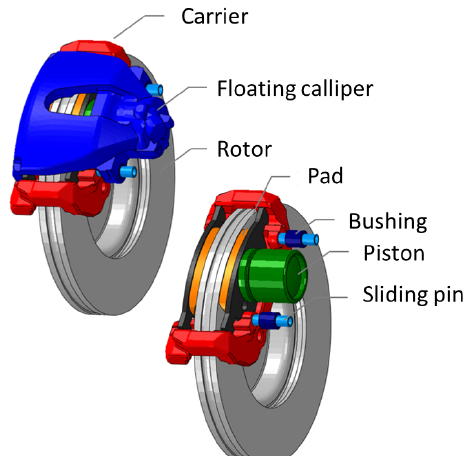
Fig. 3 Disc brake system.